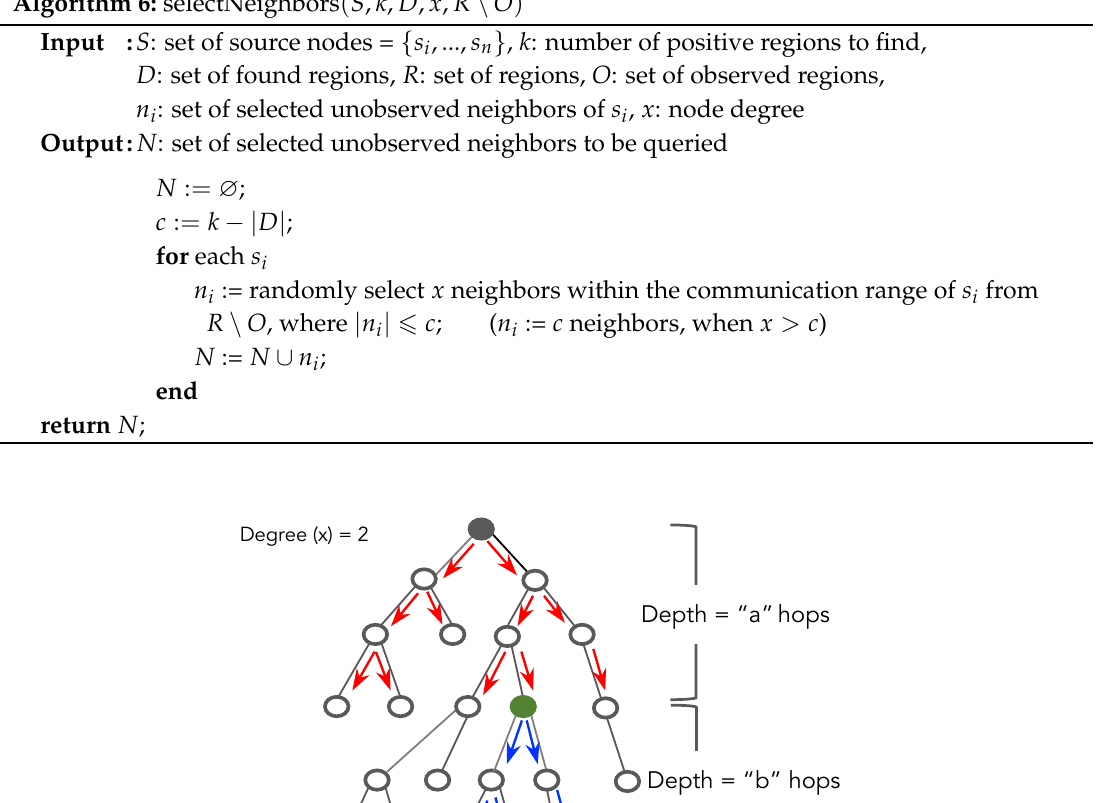
Algorithm 6: selectNeighbors ( S , k , D , x , R \ O )